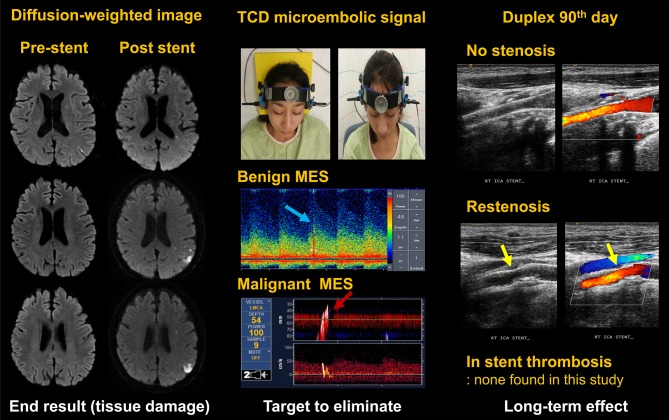
Measurement of laboratory outcomes. TCD, transcranial doppler; MES, microembolic signal. Written informed consent was obtained from the individual appearing in this figure (top, middle).